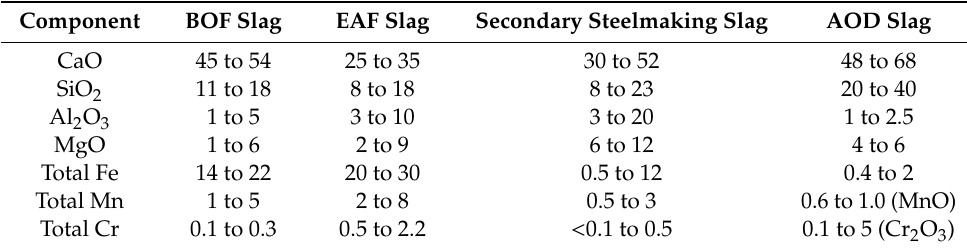
Table 1. Typical SFS composition ranges (in wt.%)